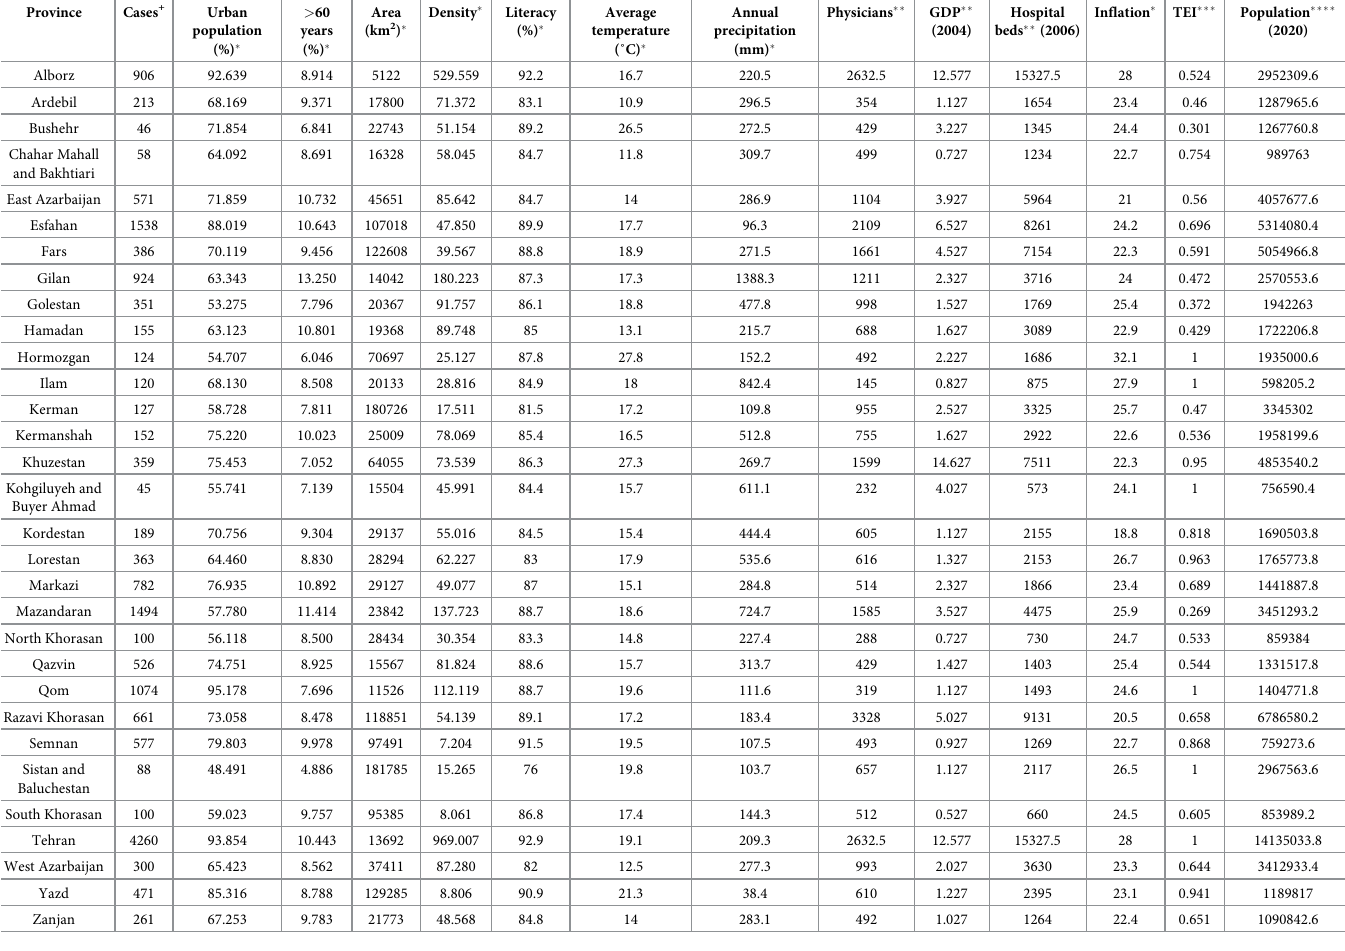
Table 1. Features extracted for spatial analyses disaggregated by Iranian provinces to predict the spread of COVID-19 cases. Abbreviations: GDP, Gross Domestic Product; TEI, Transportation Efficiency Index Province Cases